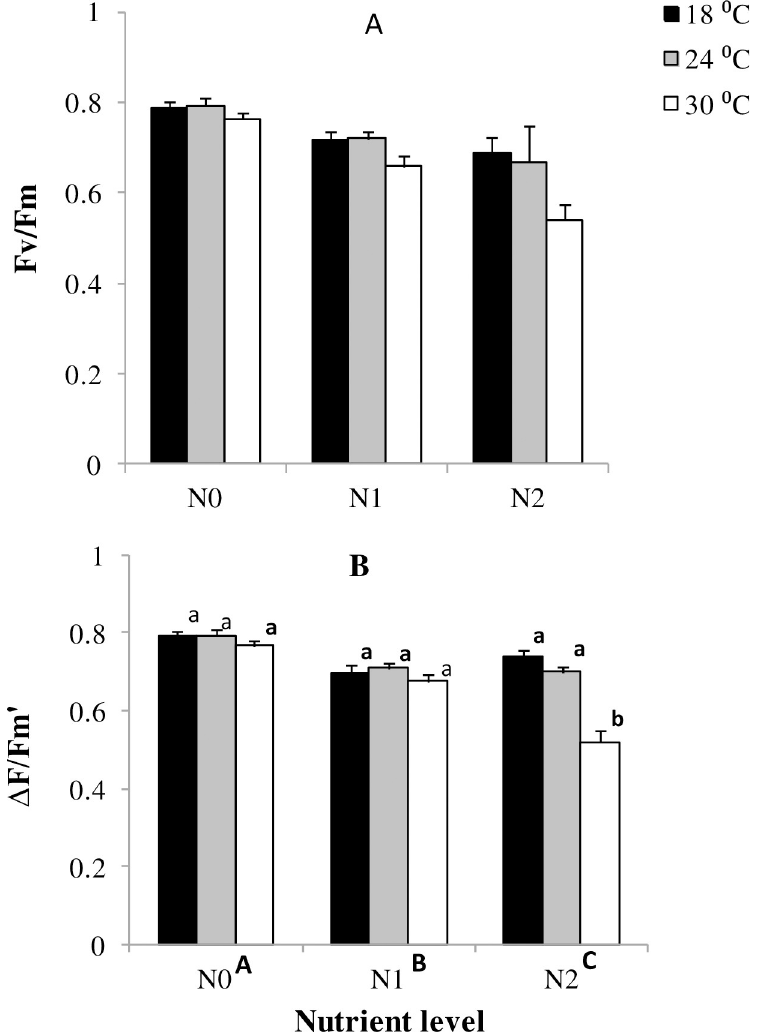
Fig 4. Main and interactive effects of temperature and nutrient treatments on maximum quantum yield and effective quantum yield of PS II in Z . capensis . Values are mean ± SE, n = 3. Different letters above bars denote differences between temperature levels within nutrient treatments. Different capital letters adjacent to nutrient levels denote differences among nutrient